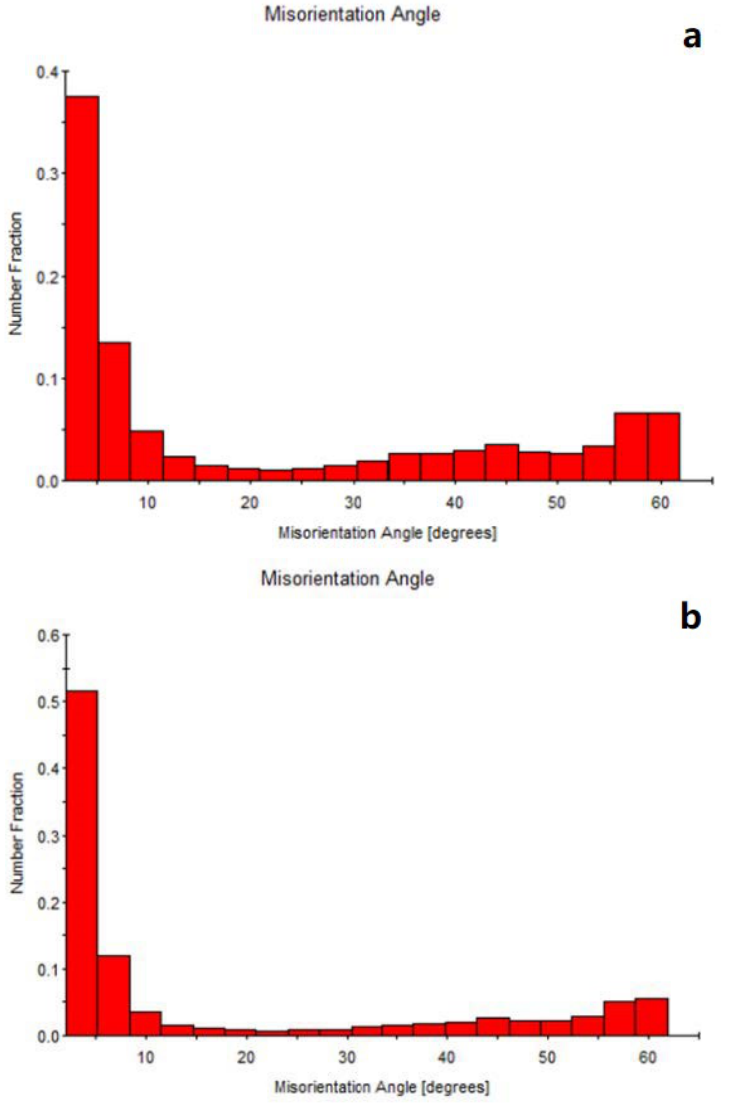
Figure 16. Grain size diameter for ( a ): 𝑇 11 ; ( b ): 𝑇 31 .